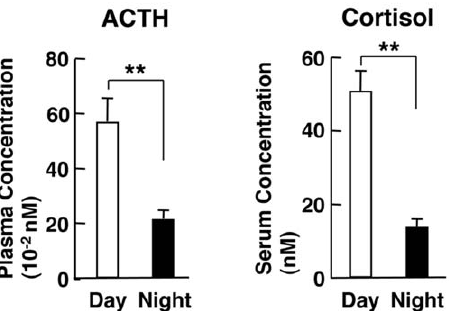
Figure 1. Concentrations of plasma ACTH and serum cortisol at 8 am and 8 pm in healthy adult volunteers. Concentrations of plasma ACTH (left panel) and serum cortisol (right panel) at 8 am (Day) and 8 pm (Night) are shown. Bars represent the mean 6 S.E. values of serum cortisol and plasma ACTH. **: P , 0.01, compared to the conditions indicated (n=10, m=10).